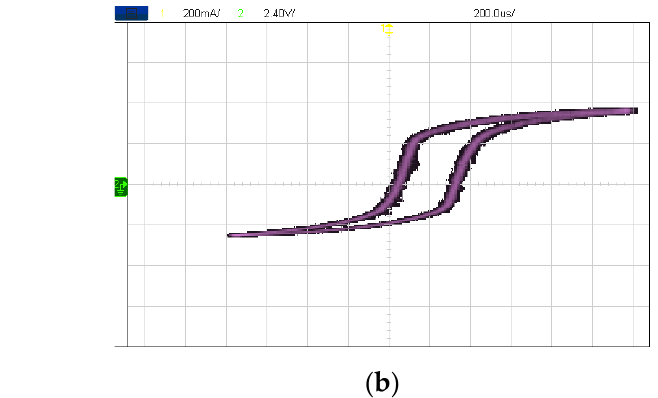
Figure 4. B – H curve plotted by oscilloscope. ( a ) Primary current (yellow) and integration of sec- ondary voltage (green, reversed from the oscilloscope setting) ( b ) B – H curve (without calibration) plotted from ( a ).